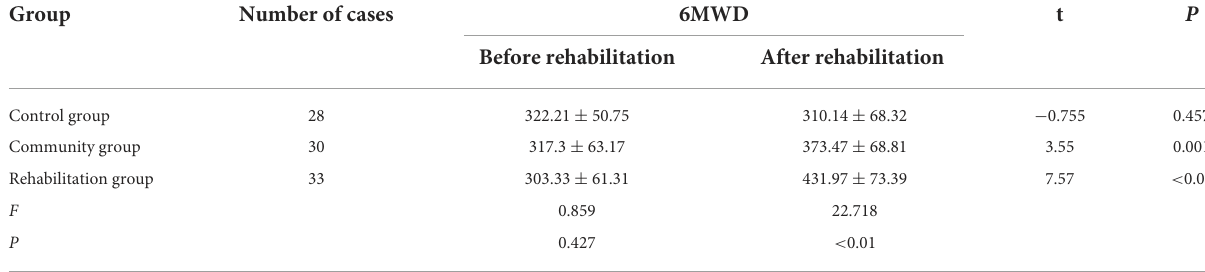
TABLE 3 Comparison of 6MWD before and after rehabilitation among the three groups ( ¯ x ± s).